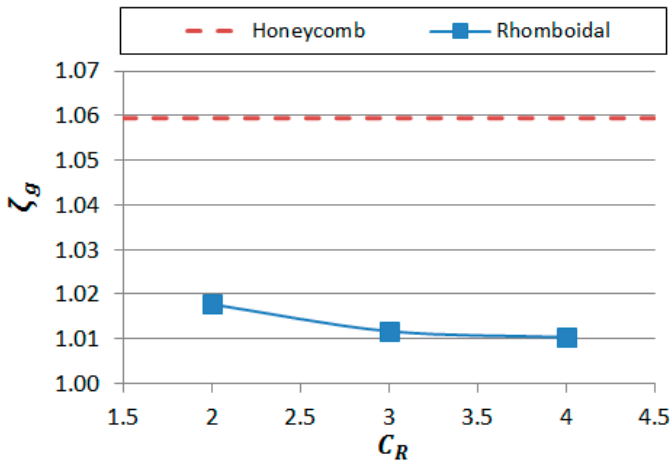
Figure 7. Geometrical increase parameter for the analyzed patterns.